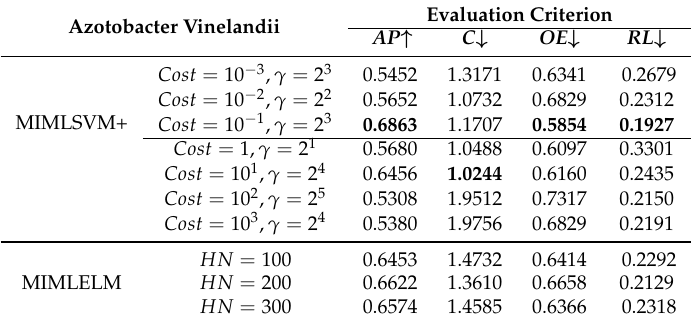
Table 5. The effectiveness comparison on the Azotobacter vinelandii (Azoto.) dataset.